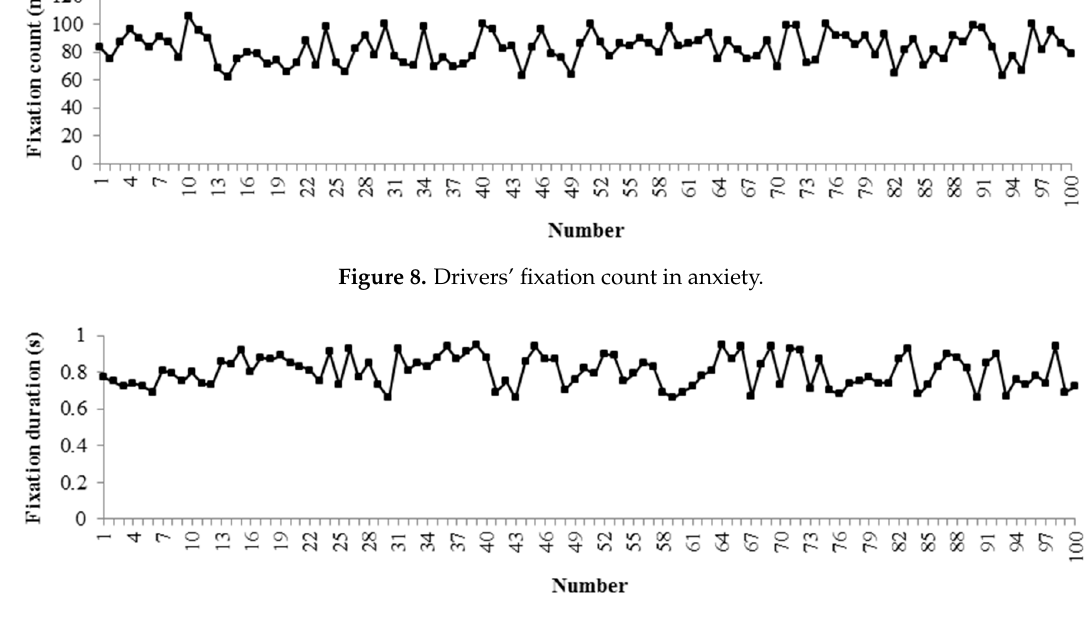
Figure 9. Drivers’ fixation duration in anxiety.